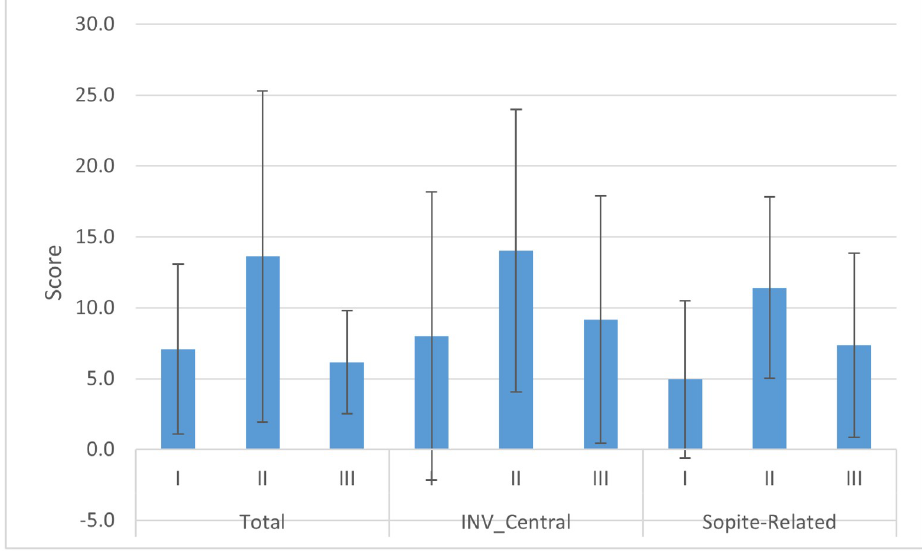
Fig 7. Mean and SD of MSAQ subcategories for the main sessions. The prefix INV- indicates that transformation was needed to comply with the normal distribution condition.